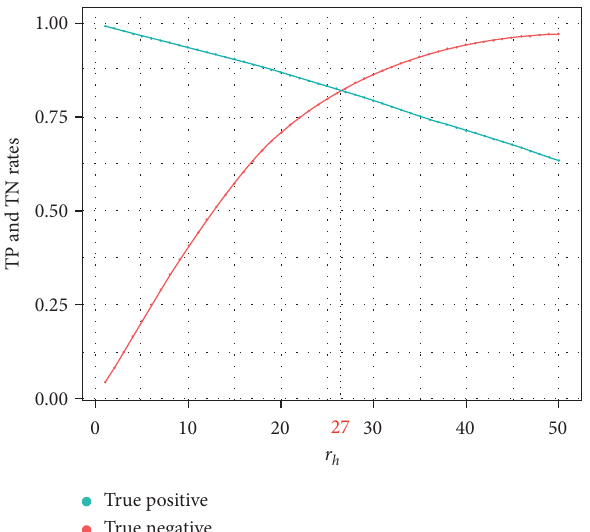
Figure 8: TP and TN rates at different r